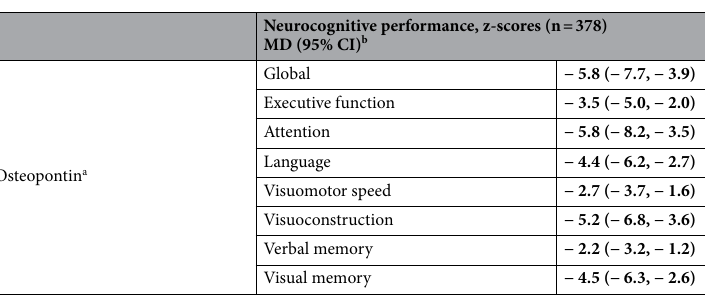
Table 6. Association of plasma osteopontin (log-transformed) with global and domain-based neurocognitive domains (in z-scores), expressed in mean difference (MD) and 95% confidence interval (CI). Bold values indicates p < 0.05 using linear regression. MD, mean difference; CI, confidence interval. a Log-transformed. b Adjusted for age, gender, education, hypertension, diabetes and cardiovascular